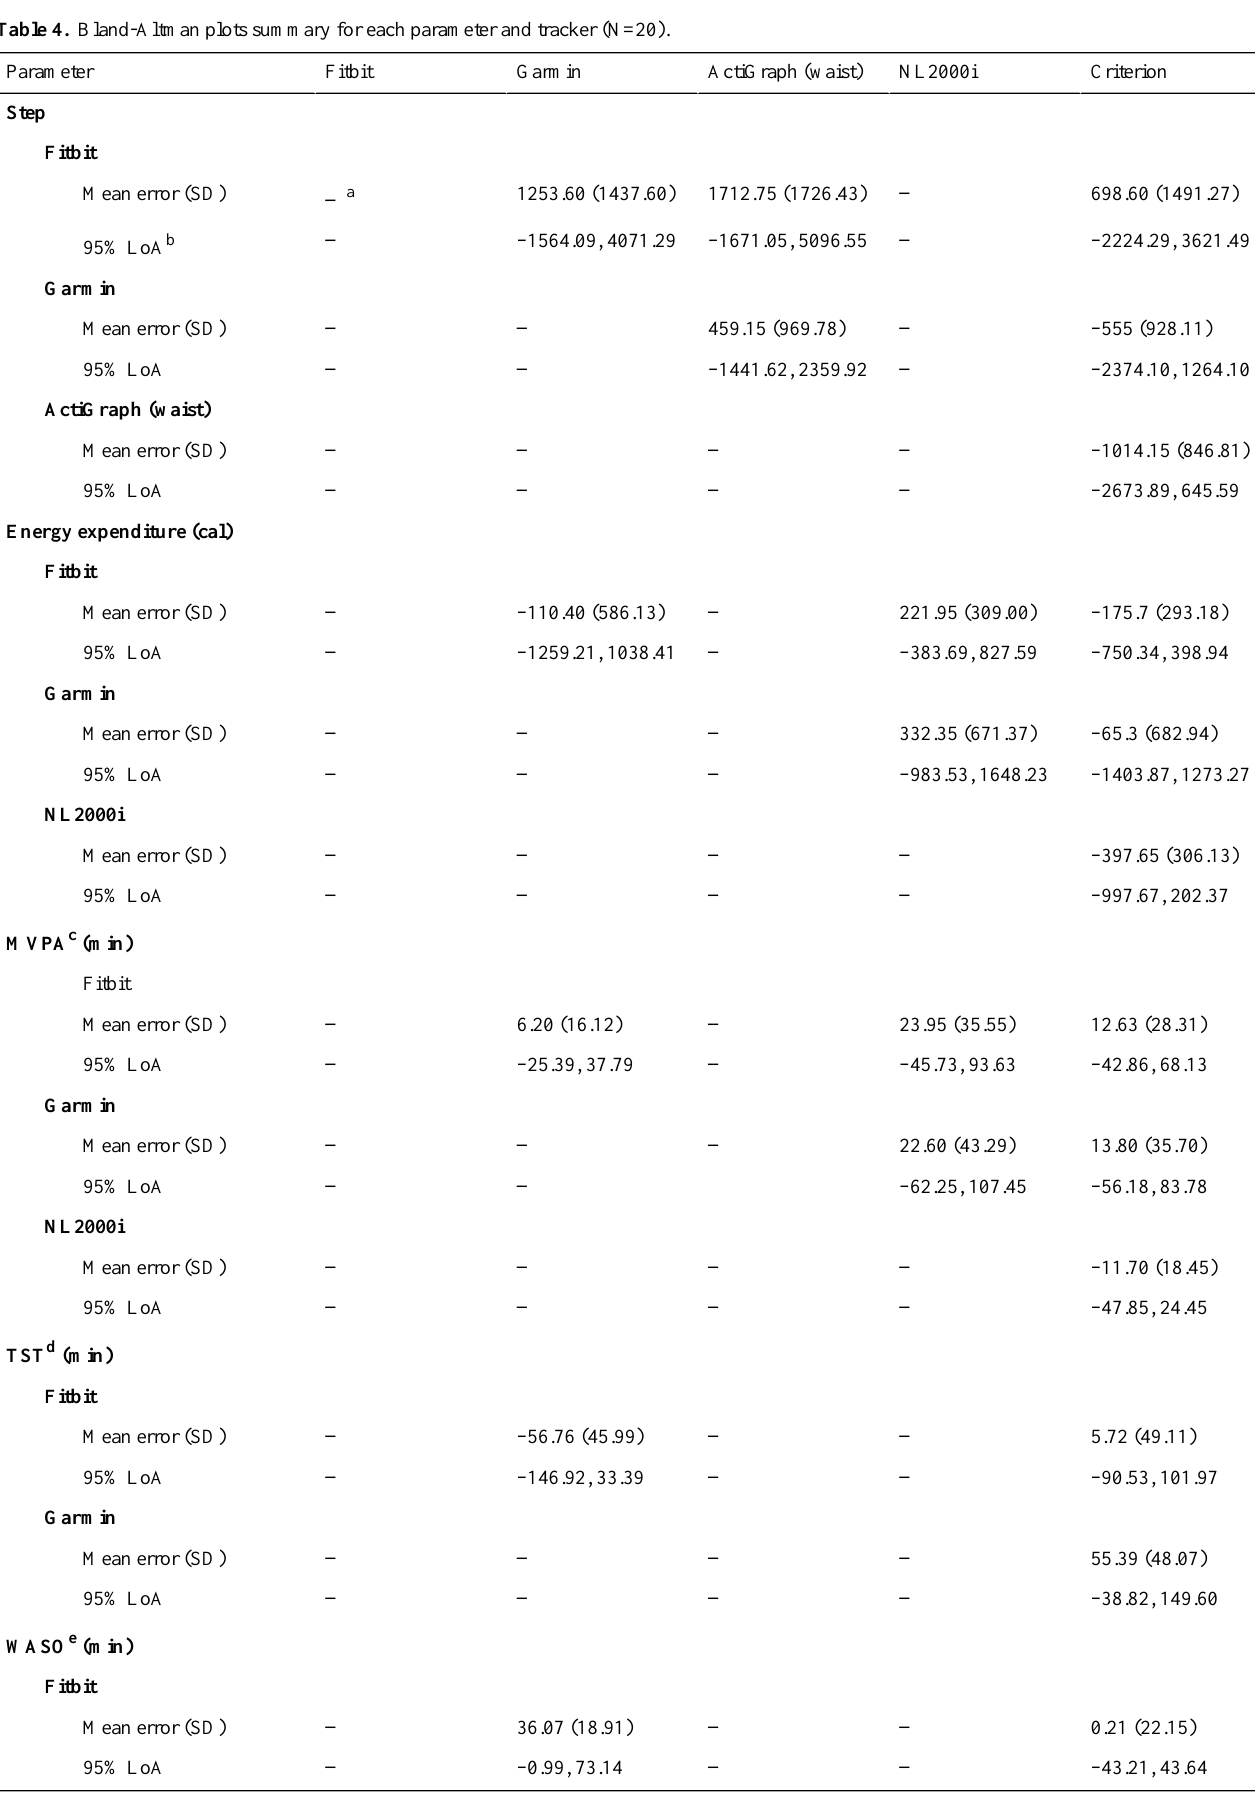
Table 4. Bland-Altman plots summary for each parameter and tracker (N=20).